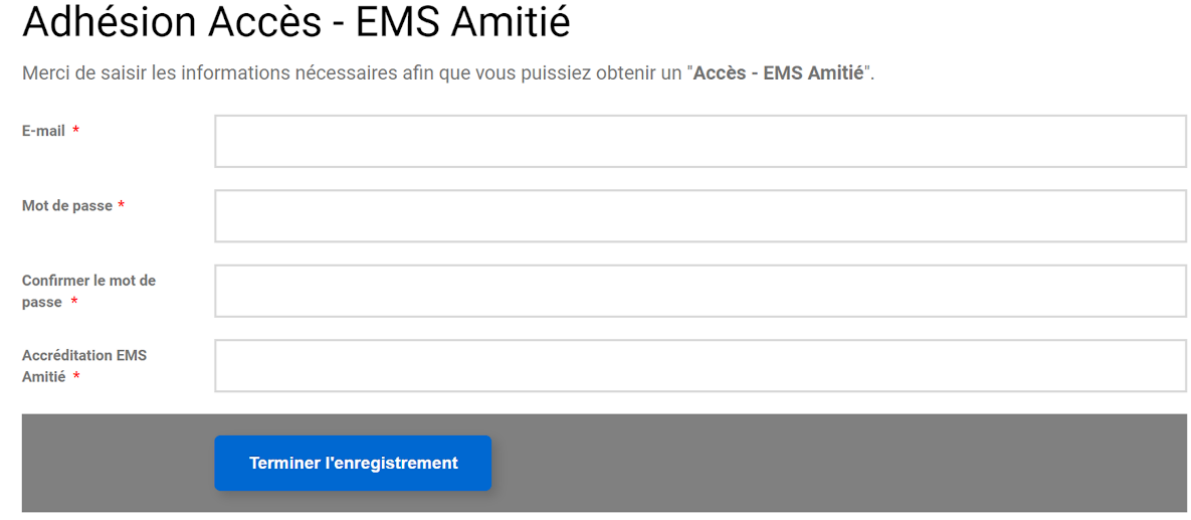
Figure 4. Registration form (in